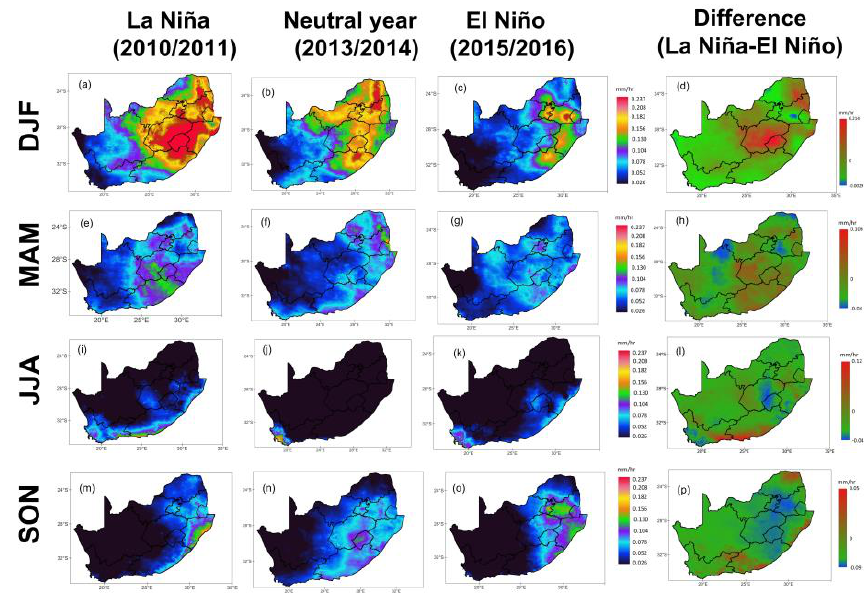
Figure 3. Seasonal mean spatial distribution of precipitation during the La Niña ( a , e , i , m ), neutral year ( b , f , j , n ) and El Niño periods ( c , g , k , o ) and the difference between the two extremes ( d , h , l , p ).